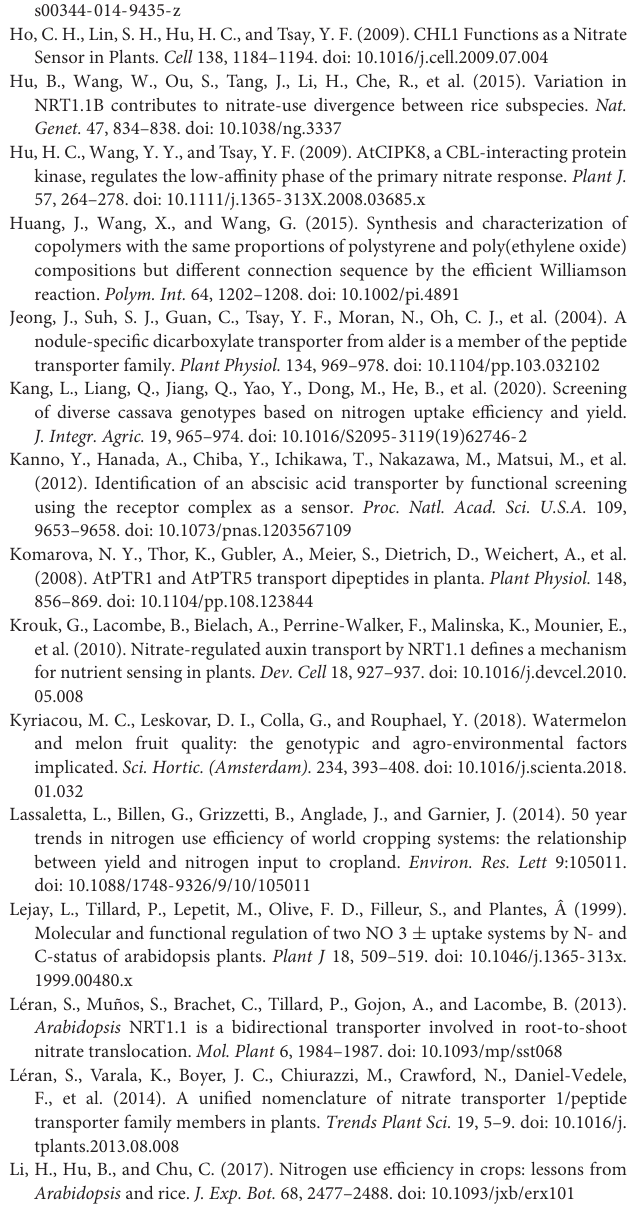
Supplementary Figure 1 | Southern blotting analysis of MeNPF4.5 transgenic plants. WT, wild type; M, marker; OE22-OE34: MeNPF4.5 overexpress transgenic plants. The probes were HPT in left three samples and MeNPF4.5 in right three samples, and the restriction endinuclease was Hind